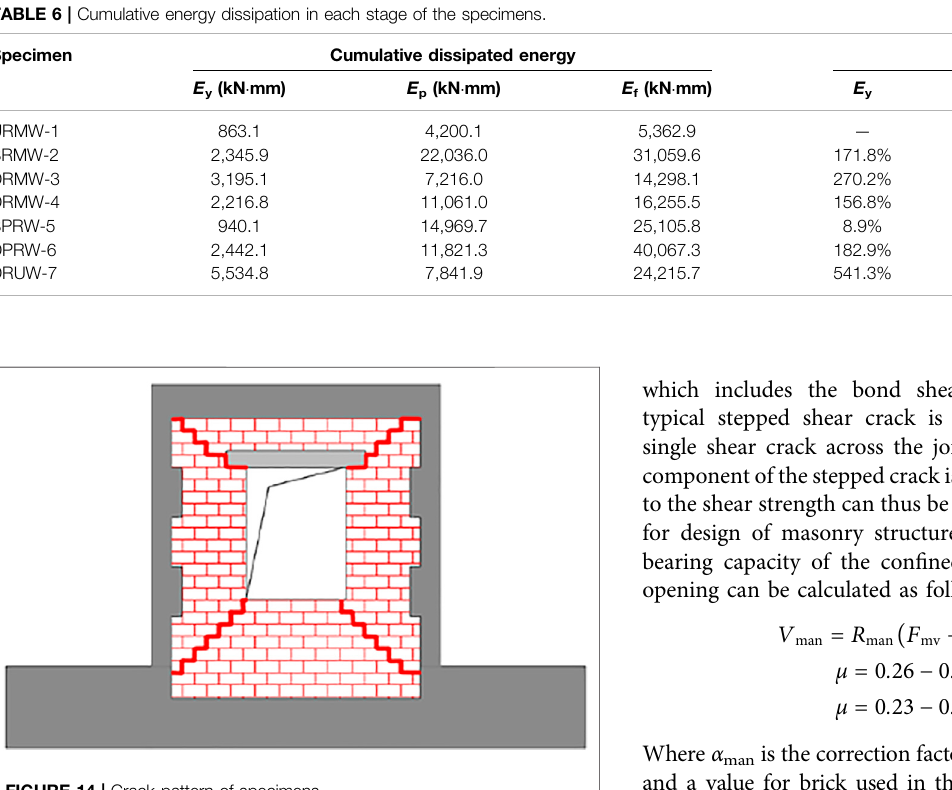
FIGURE 14 | Crack pattern of